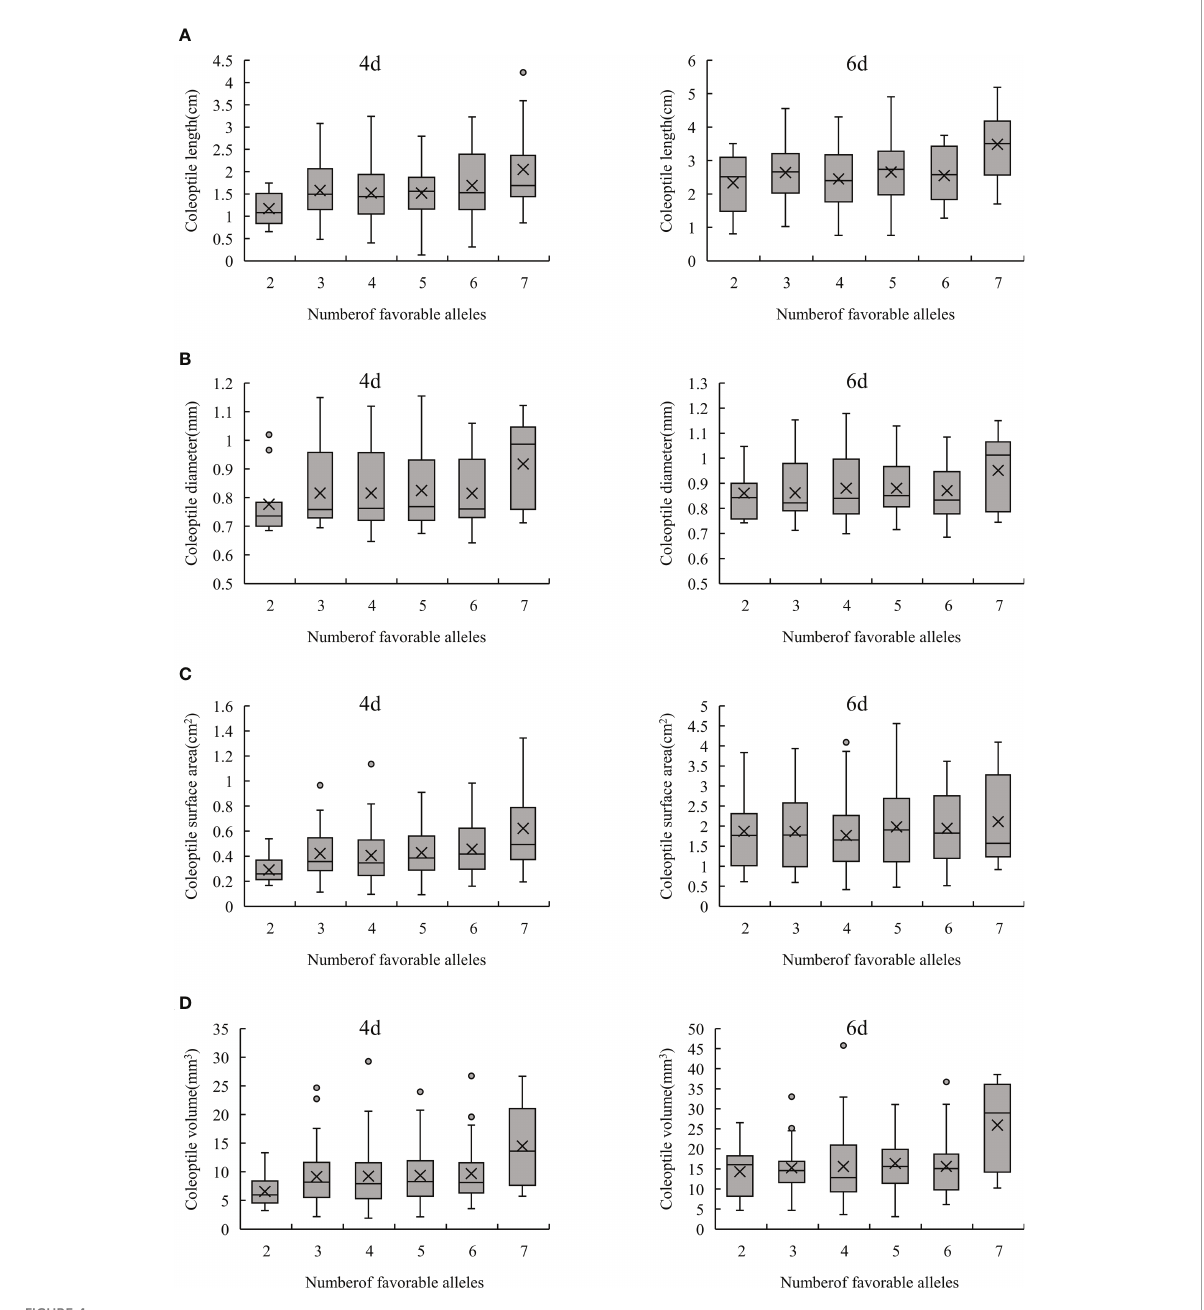
FIGURE 4 Phenotypic analysis of favorable alleles aggregation. (A – D) represents CL, CD, CSA and CV,